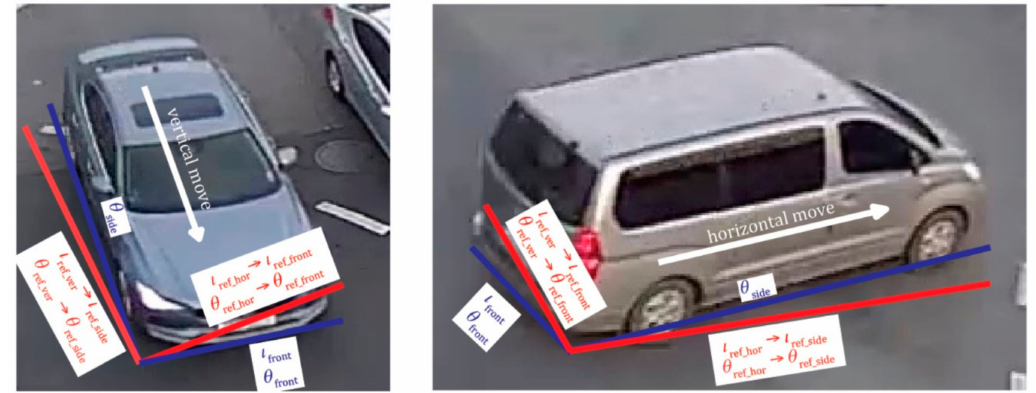
Figure 9. The relationships between the geometric parameters of a moving